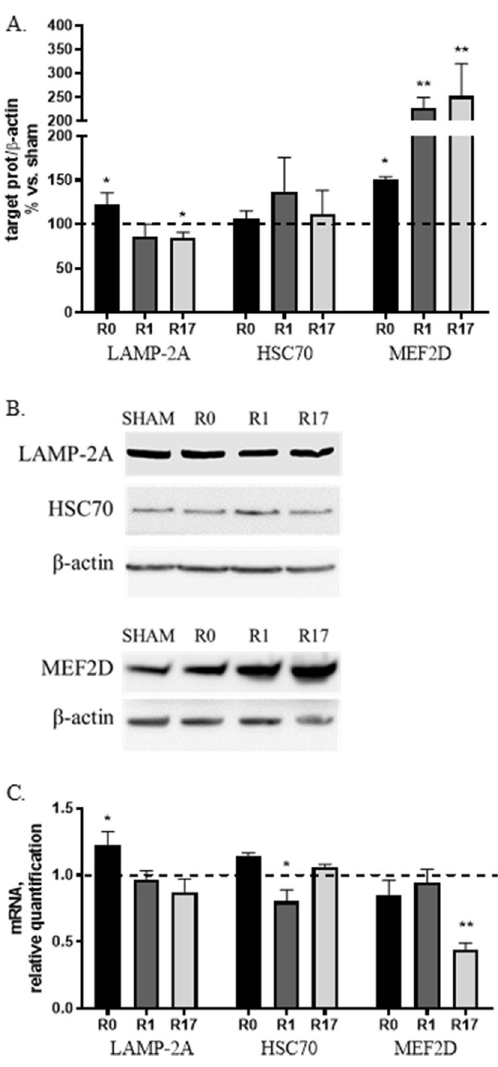
Figure 3. Effects of DCS on protein ( A , B ) and gene ( C ) expression of CMA markers (LAMP-2A, HSC70, MEF2D) in SH-SY5Y cells under basal conditions at the end of stimulation (R0), after 1 and 17 h (R1 and R17). A down-regulation of CMA was found in DCS-treated cells. ( B ) Representative Western blot image showing immunoreactivity at different time points (R0, R1 and R17) for LAMP-2A, HSC70, MEF2D and β-actin, used as internal standard, in cells exposed to DCS or sham. Full-length blot for MEF2D and available cropped blot for LAMP-2A and HSC70 are presented in Supplementary M&M. (N = 3; **p < 0.01, *p < 0.05 vs.